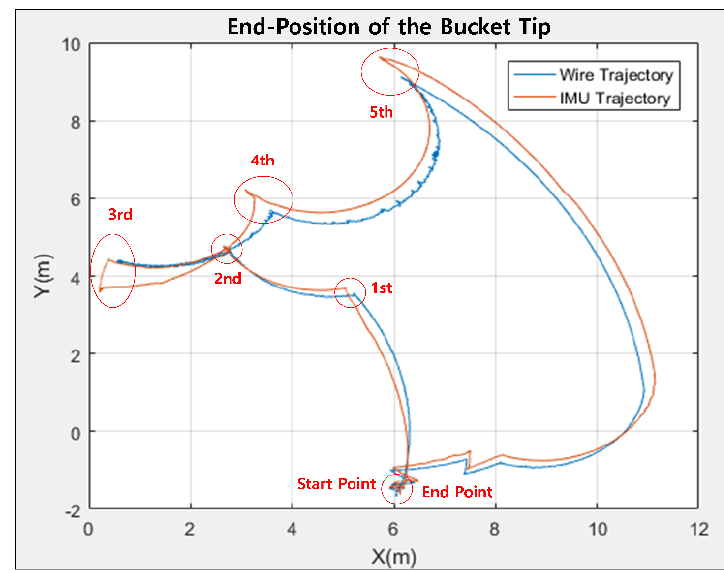
Figure 15. Bucket tip trajectories when all joints are moving